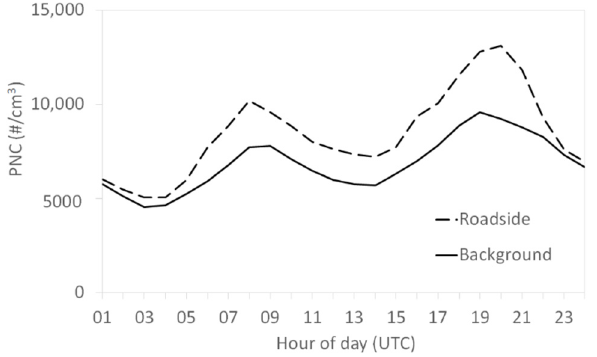
Figure 6. Particle number concentration (PNC) average daily profile from hourly data at both sites over the measurement period.